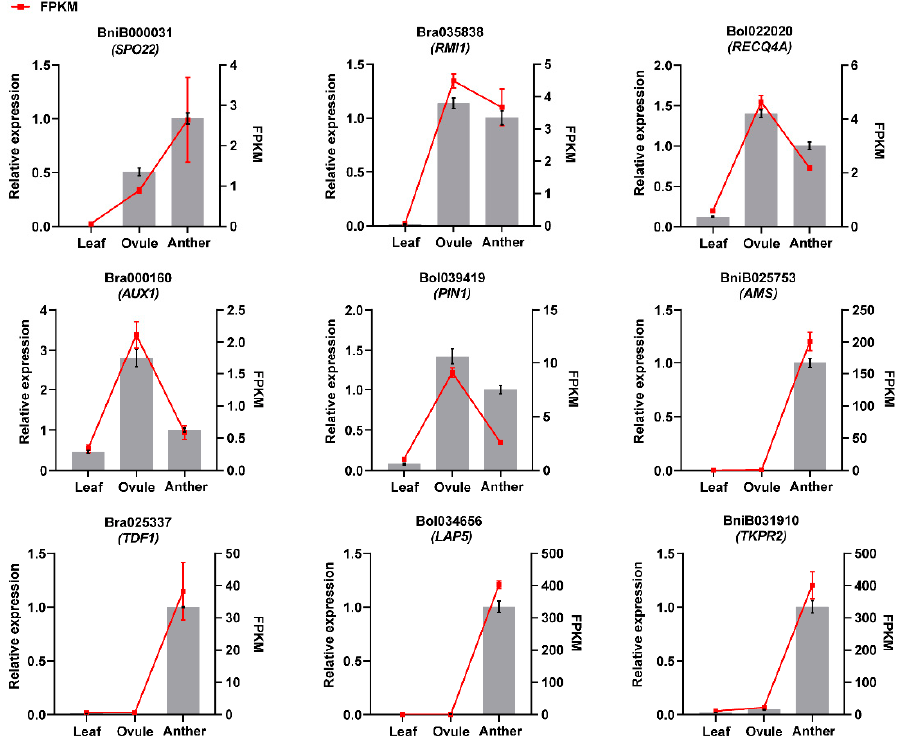
Figure 8. RT-qPCR analysis of nine randomly selected genes. RT-qPCR results are shown by grey columns, and RNA-Seq findings are represented by red